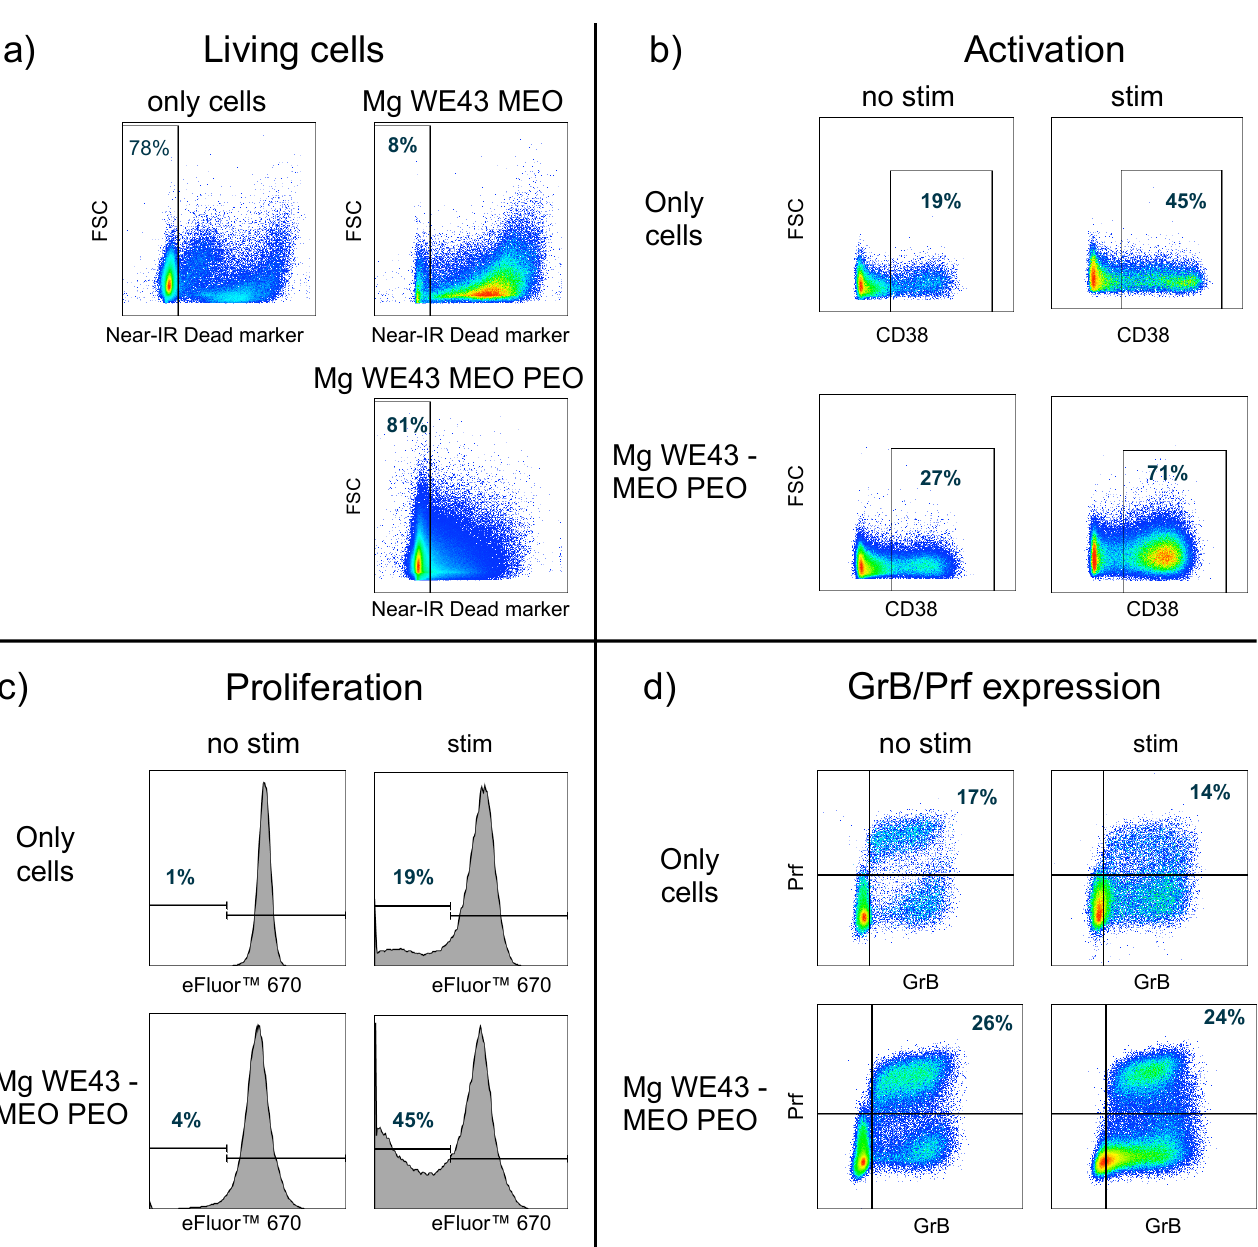
Figure 7. Effects on primary human lymphocytes: ( a ) living cells among total PBMC, detected using a fixable near-IR viability kit (Thermo Fischer, Waltham, MA, USA) ( b ) activation of CD8 + T cells (measured by determining the surface expression of CD38), ( c ) proliferation of CD8 + T cells (measured by determining the number of cells with low fluorescence intensity for the proliferation tracking dye eFluor™ 670. The dye is distributed equally between daughter cells upon cell division, thus, proliferation can be measured as successive reduction of the fluorescence intensity of the cells), ( d ) expression of granzyme B and perforin on CD8 + T cells. ( b – d ) show representative plots of two experiments with at least 200,000 cells acquired per setting in each